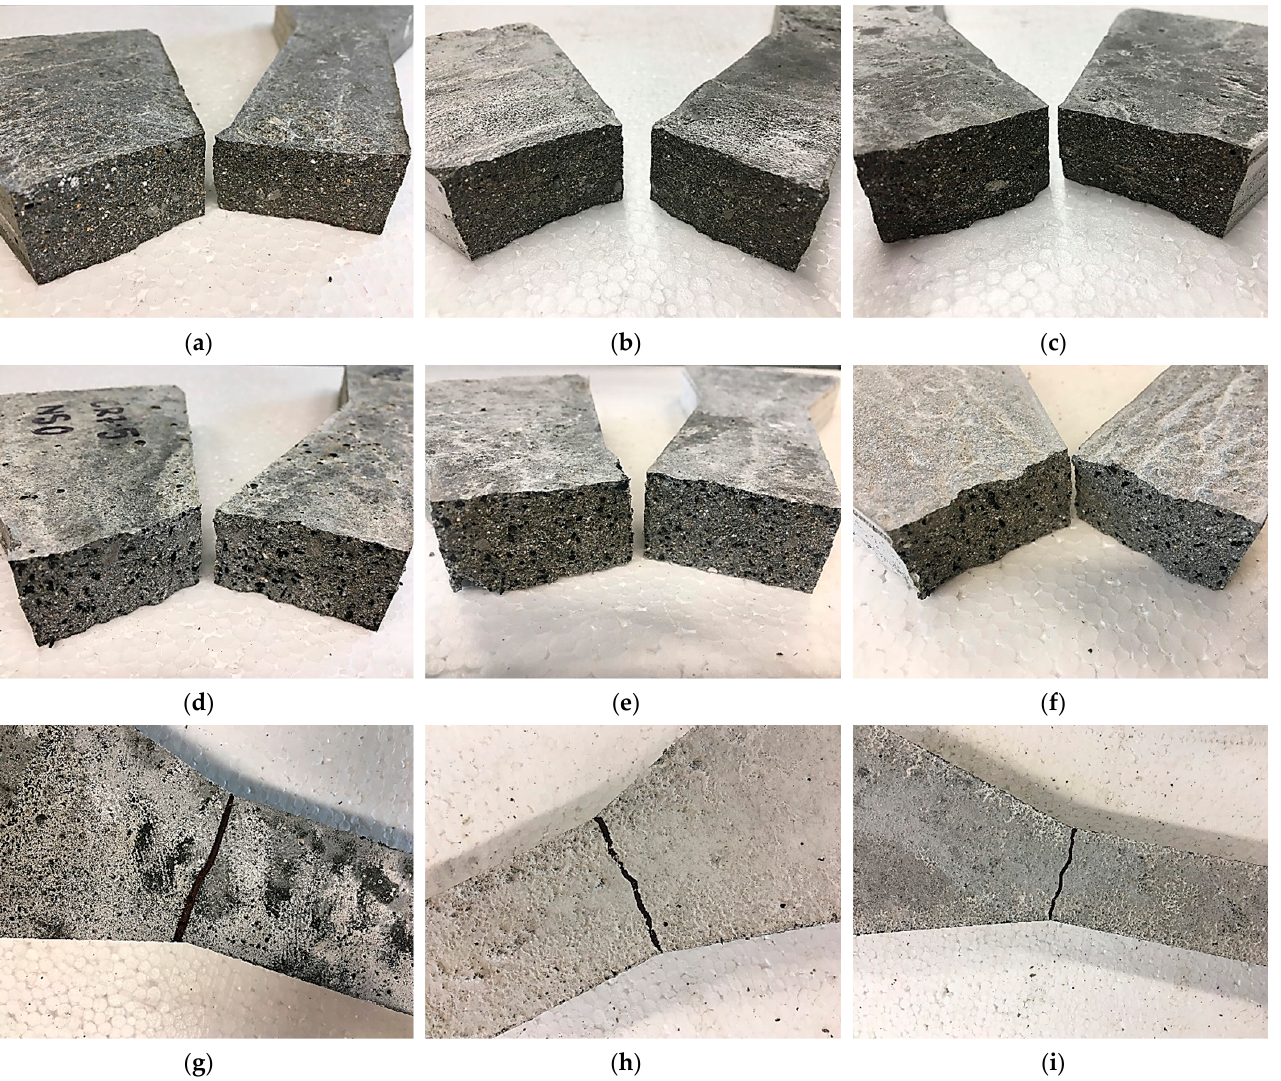
Figure 7. Tested dog-bone samples of NS-CRM mixes at 28 days: ( a ) CR0-NS0; ( b ) CR0-NS2.5; ( c ) CR0-NS5; ( d ) CR7.5-NS0; ( e ) CR7.5-NS2.5; ( f ) CR7.5-NS5; ( g ) CR15-NS0; ( h ) CR15-NS2.5; ( i ) CR15-NS5.